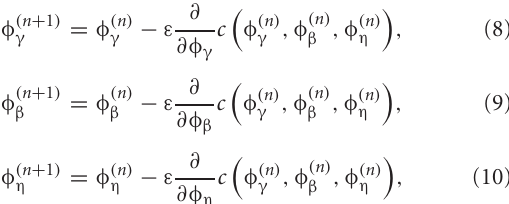
FIGURE 3 | Starch, sucrose, and rhythm profiles. Evolution of starch (A) and sucrose (B) profiles during gradient descent. All of three processes, carbon partitioning ( γ ( t ) ), starch degradation ( β ( t ) ), and sucrose export ( η ( t ) ), are assumed to be circadian regulated. Black color stands for initial profile with all phase shifts equal to 0 whereas red shows profile at convergence of the gradient descent. Starch profiles (C) for L/D cycles of 6h/18h (blue), 8h/16h (purple), 10h/14h